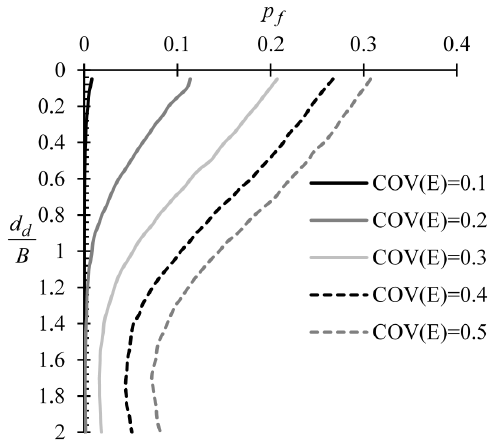
Figure 8. versus example curves for θ = 10 m, x/B = 0 and different footing widths B . d d B